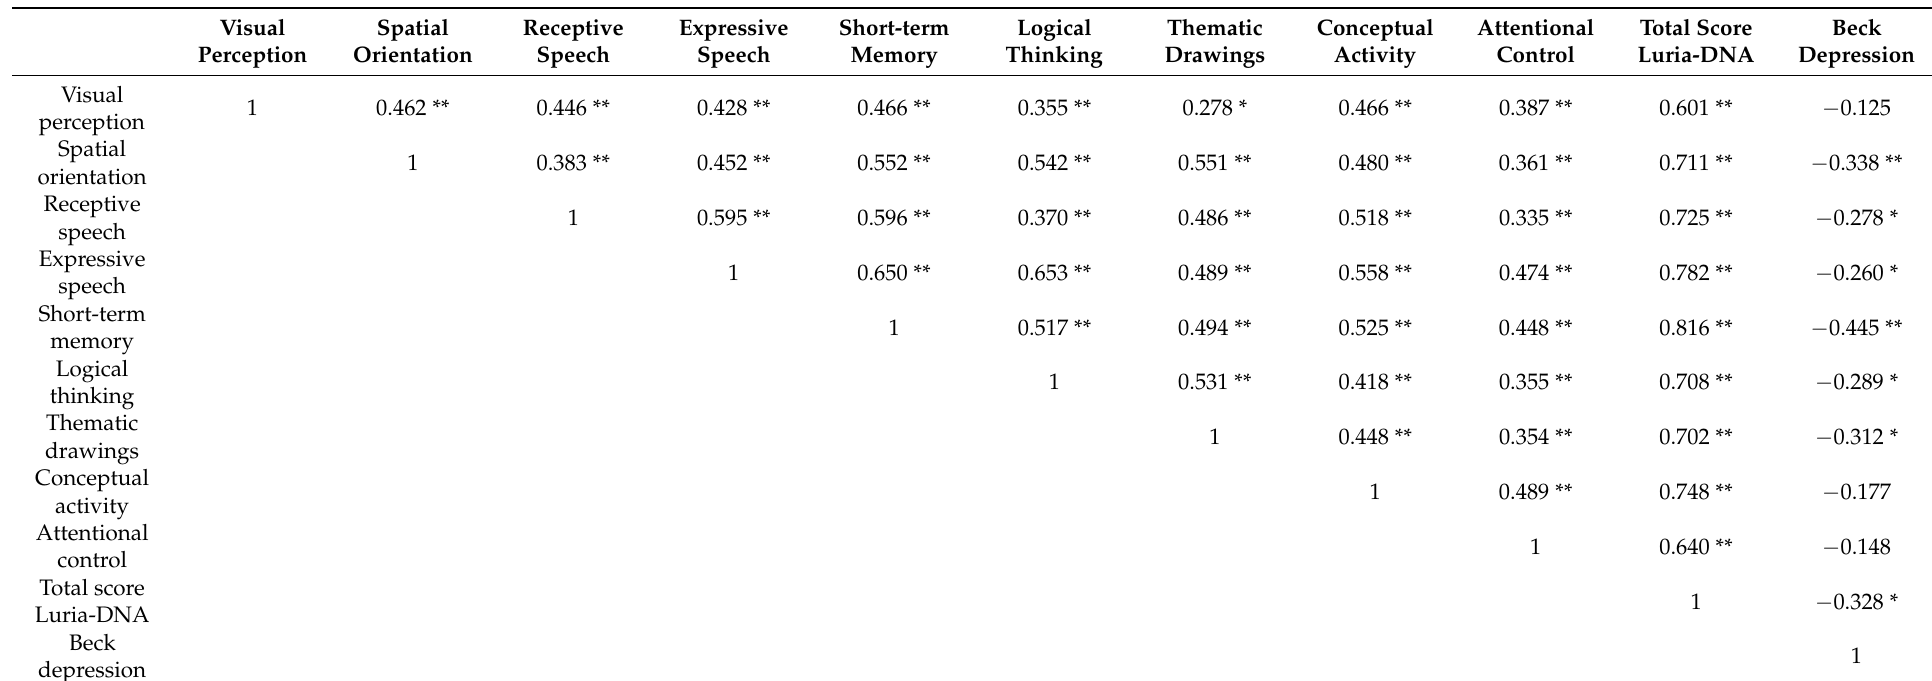
Table 1. Correlations between neuropsychological and depressive variables